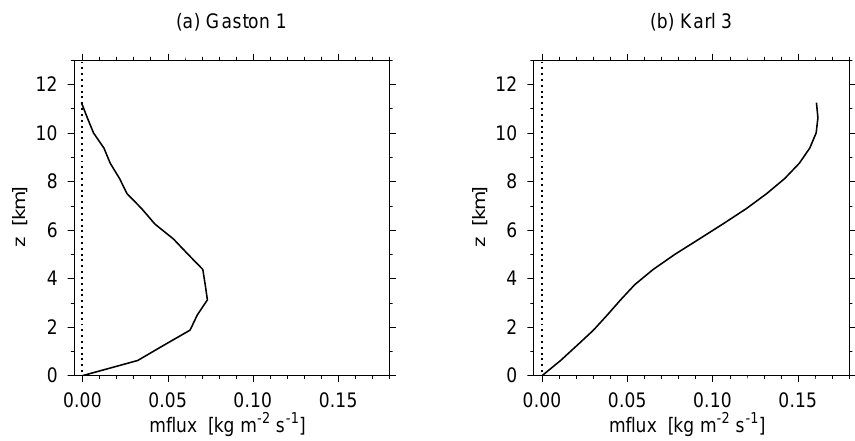
Fig. 7. Vertical mass flux profiles averaged over the black boxes in Fig. 6 for Gaston 1 (left) and Karl 3 (right).